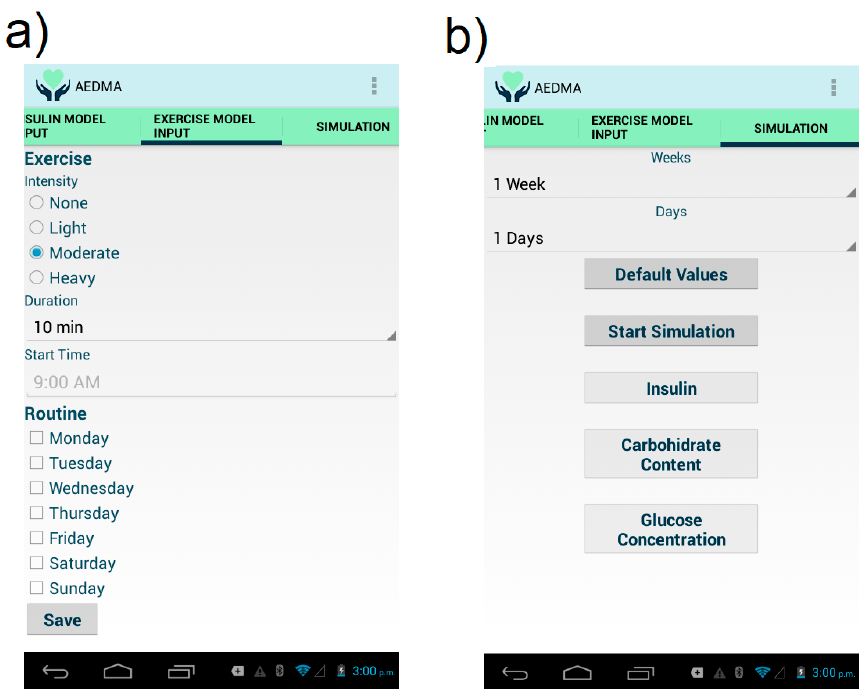
Figure 4. The last two configuration screens. ( a ) Components of the exercise model Table. ( b ) Components of the simulations tab.